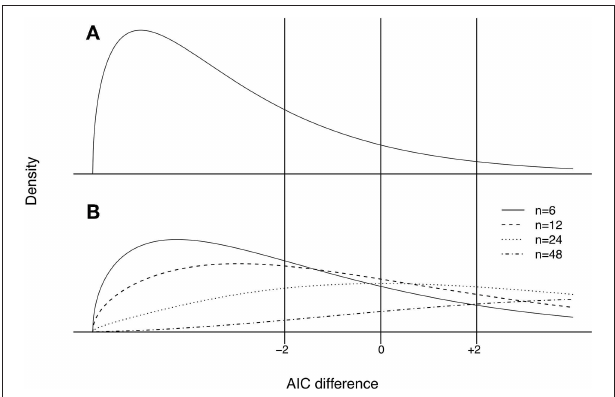
FIGURE 8 | (A) Location-shifted chisquare distribution of the difference of AIC values, when data arise from model 1 nested within model 2. In this plot, the degrees of freedom for this distribution are equal to ν 3, and the shift to the = left of 0 is equal 2 ν 6 (see Equation 77 and text below it). This chisquare = distribution is invariant to sample size. As a result, the areas under this distribution in the intervals ( 2, 2) and ( 2, ) corresponding to W 1 and M 1 , − + + ∞ respectively, are invariant to sample size. (B) Non-central chisquare distribution of the difference of AIC values, when data arise from model 2 (but not model 1), plotted for different sample sizes. This distribution is also location-shifted but its non-centrality parameter λ , which determines both its mean and n (1 / 4). As a variance, is proportional to sample size. In this illustration, λ = result, the areas under the intervals ( 2 ν , 2) and ( 2, 2) corresponding to − − − + the error probabilities M 2 and W 2 decrease as the sample size